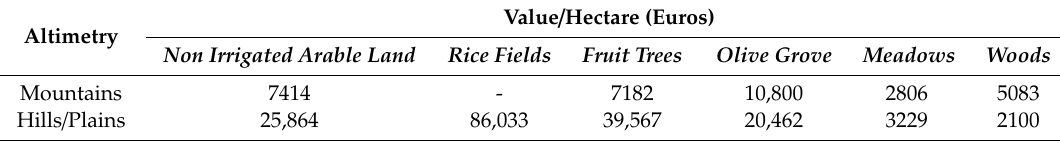
Table 2. Monetary values of agricultural areas and crops in the study area.